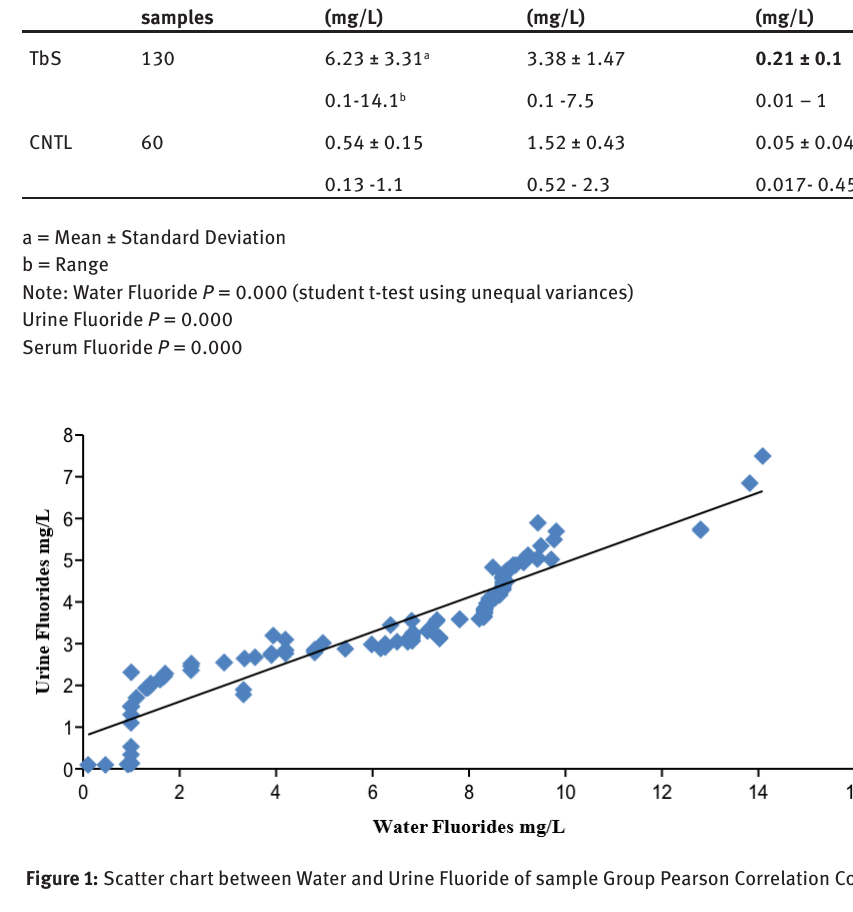
Table1: Level of Fluoride in Water, Urine and Serum. Village s Number (No.) of